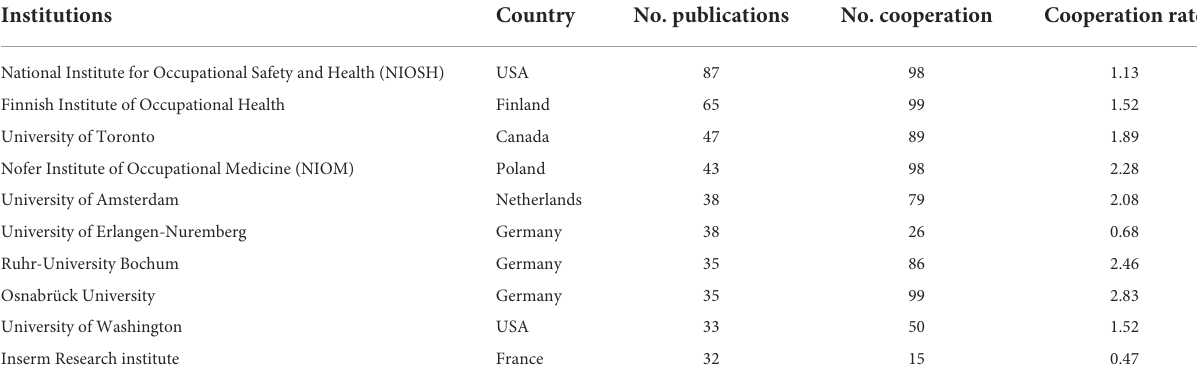
TABLE 6 Top 10 institutions in producing studies on occupational diseases.